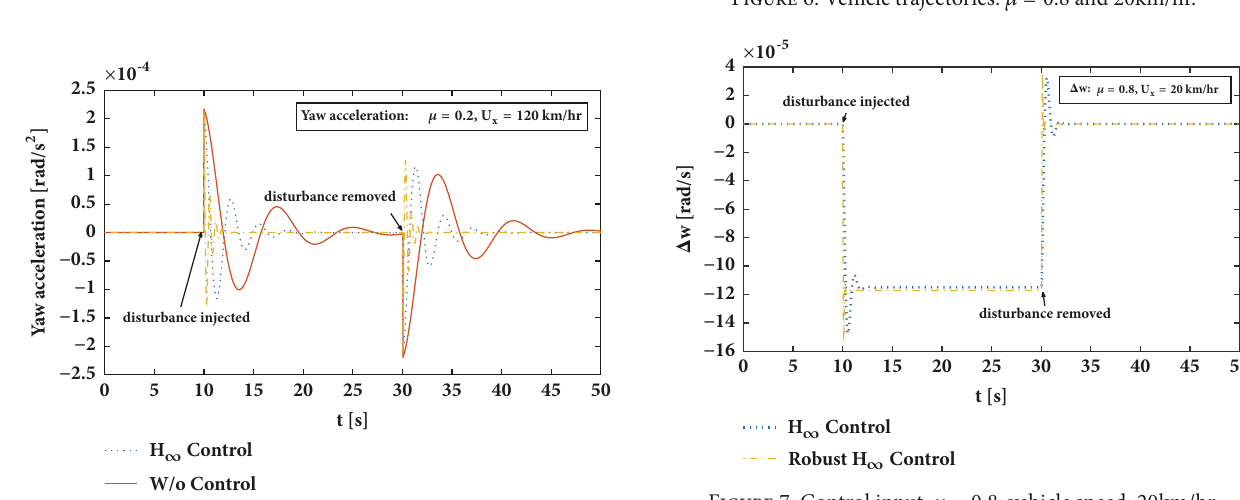
Figure 6: Vehicle trajectories: 𝜇 = 0 .8 and 20km/hr.